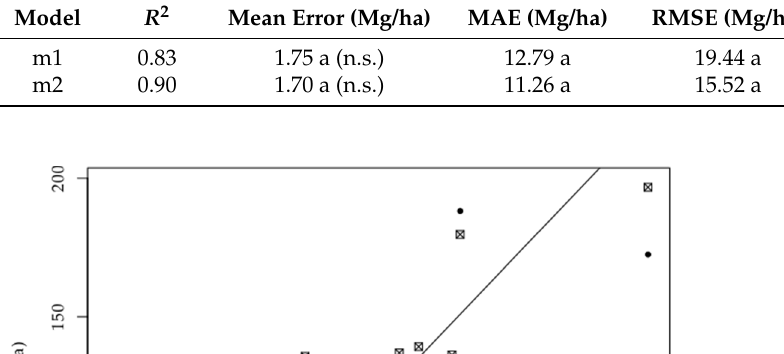
Table 4. Evaluation of biomass predictions at plot level (27 plots studied) using a leave-one-out approach. For the mean error, a negative value corresponds to an underestimation of the prediction. n.s = not significant. The RMSEr (relative root mean square error) was calculated using RMSEr = RMSE The letters correspond to the groups identified by a paired test of Student comparing the means of signed errors per plot (for the mean error) and a paired test of Wilcoxon comparing the medians of errors (for the mean absolute error MAE and the root mean square error RMSE).